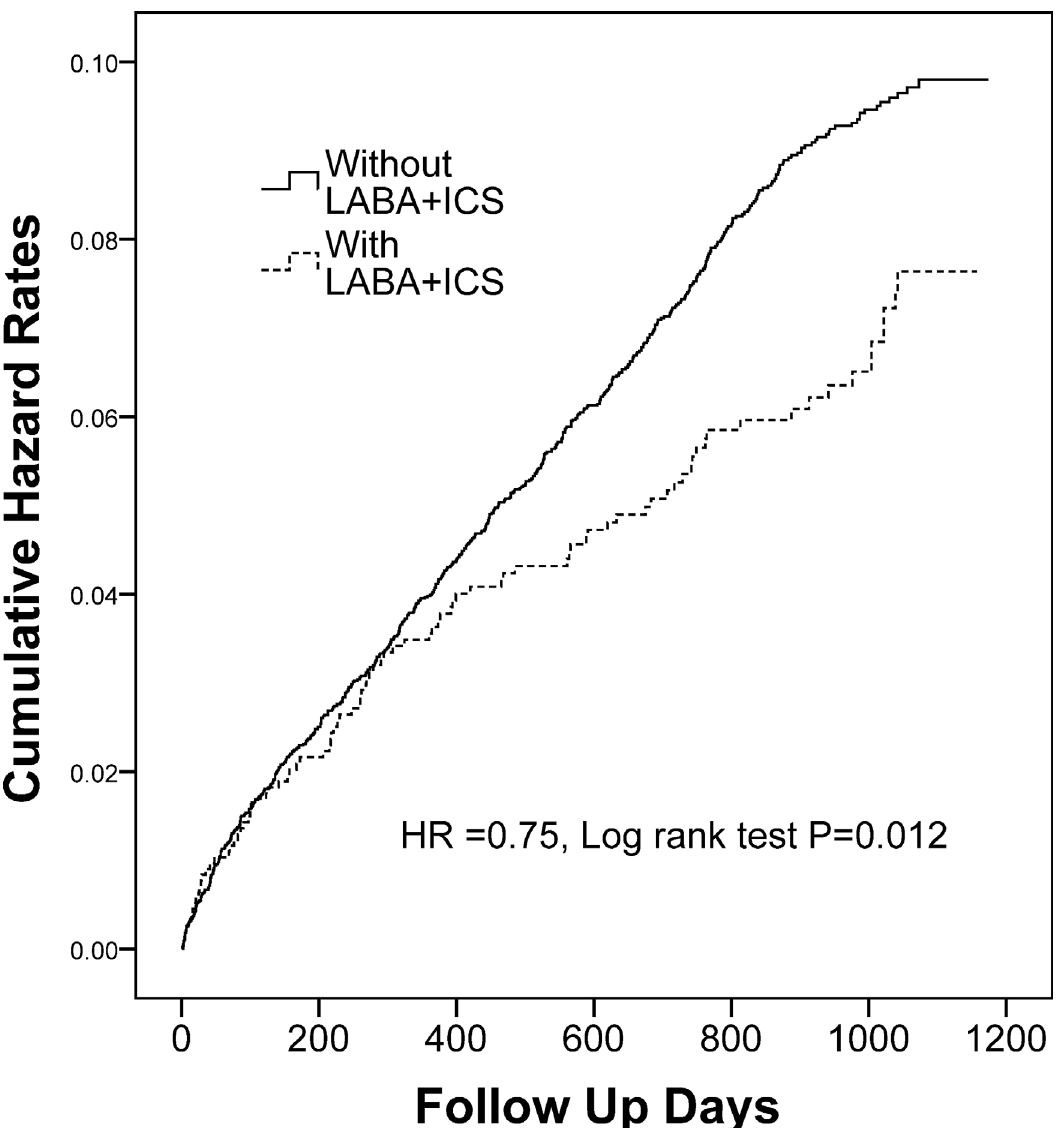
Fig 2. Cumulative incidence of stroke in COPD patients treated with and without inhaled LABA plus ICS. COPD = chronic obstructive pulmonary disease; LABA = long-acting β -agonist; ICS = inhaled corticosteroid.